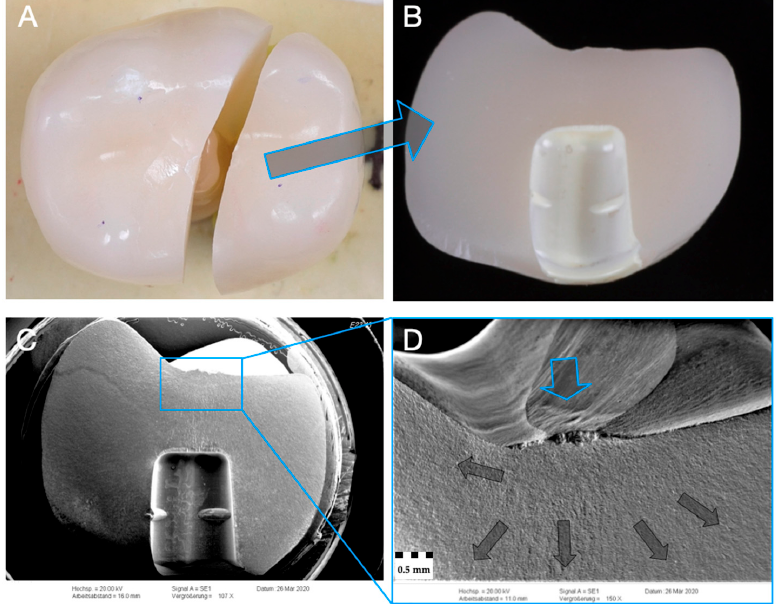
Figure 8. Representative specimen of Group E after single-load-to-fracture assessment. Light microscopy shows ( A ) occlusal view of bulk fractured specimen and ( B ) side view of fractured part marked with blue arrow. SEM: ( C ) overview of fractured part at low magnification of ( B ). Detailed view at high magnification ( D ): blue arrow indicates fracture initiation point, while dark arrows represent the direction of crack